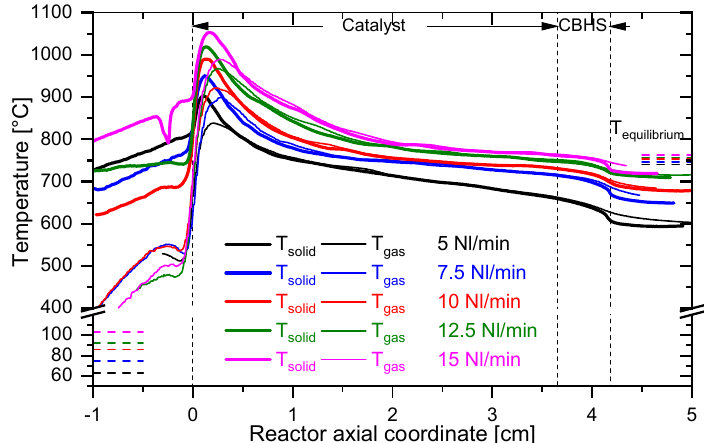
Figure 2. Experimental temperature profiles varying the inlet flow rate. Feed composition: iC8 = 3%, Air with C/O = 0.9 and N 2 complement (T solid measured with an optcal fiber and T gas measured with a thermocouple ).